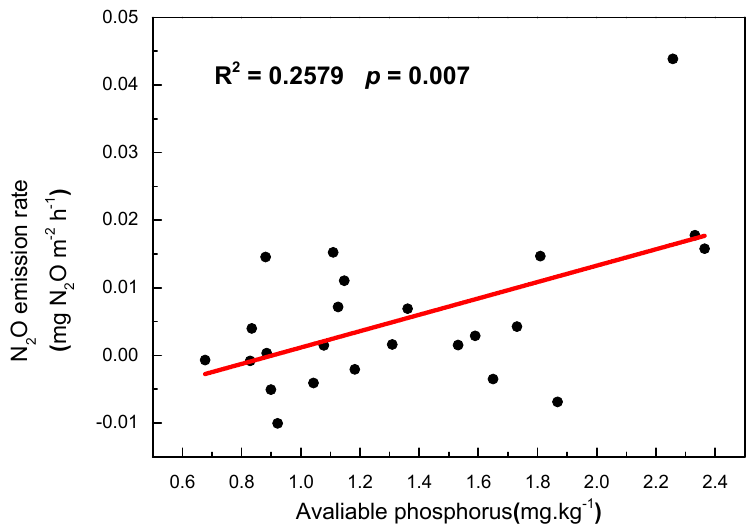
Figure 5. Linear correlation between the mean soil N 2 O fluxes and available phosphorus in 2013.